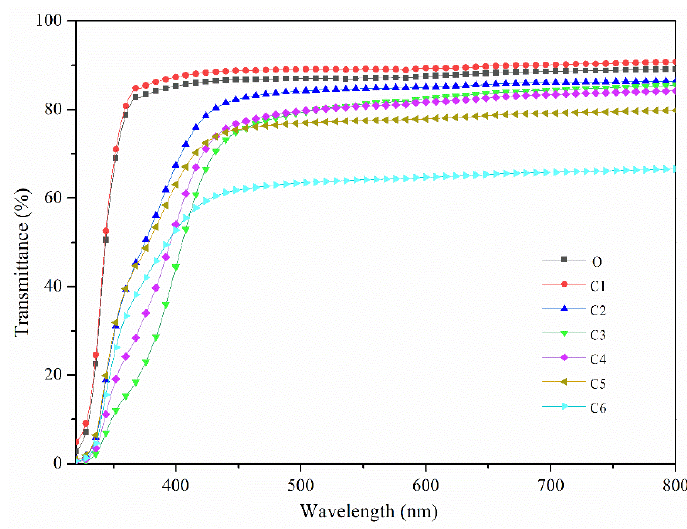
Figure 2. Transmittance spectra of the coatings O and C1~C6.